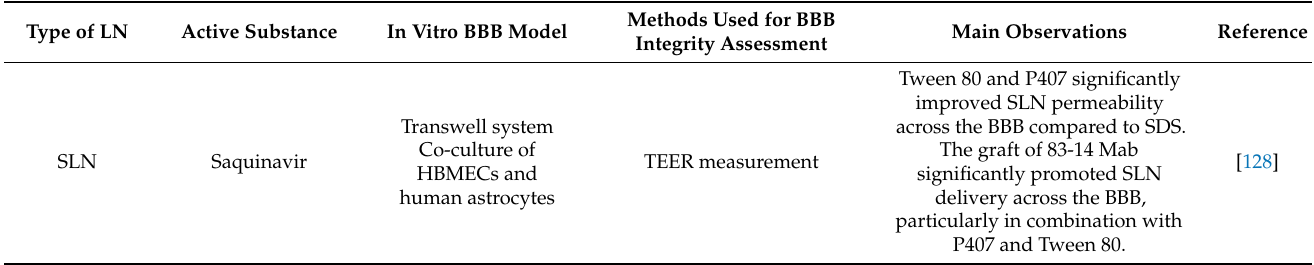
Table 5. Exemplary studies that utilized various in vitro BBB models during the development of parenteral lipid-based nanoparticles developed for the treatment of CNS